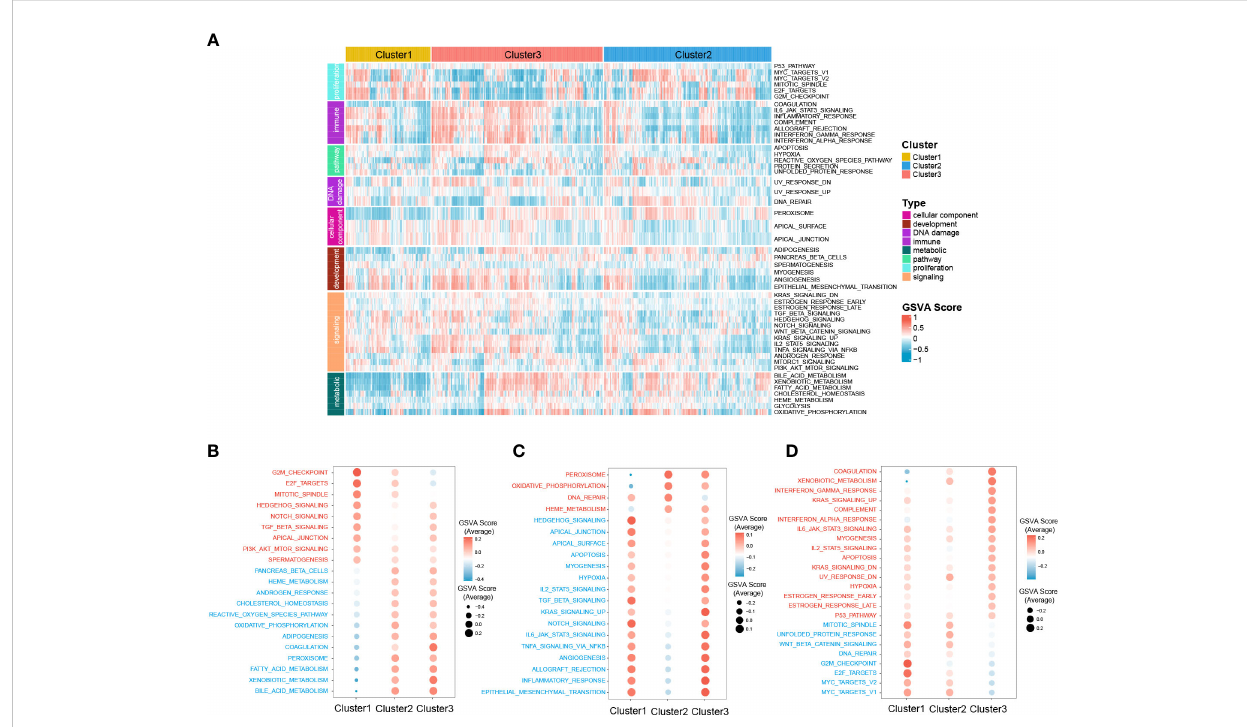
FIGURE 5 Difference of 50 hallmark gene sets among the three clusters. (A) Heatmap plot shows the GSVA score of 50 hallmark gene sets of the three clusters in RNA-seq cohort. The hyperactive and hypoactive processes or pathways in Cluster1 (B) , Cluster2 (C) , and Cluster3 (D) . Red represents hyperactive process or pathway and blue represents hypoactive process or